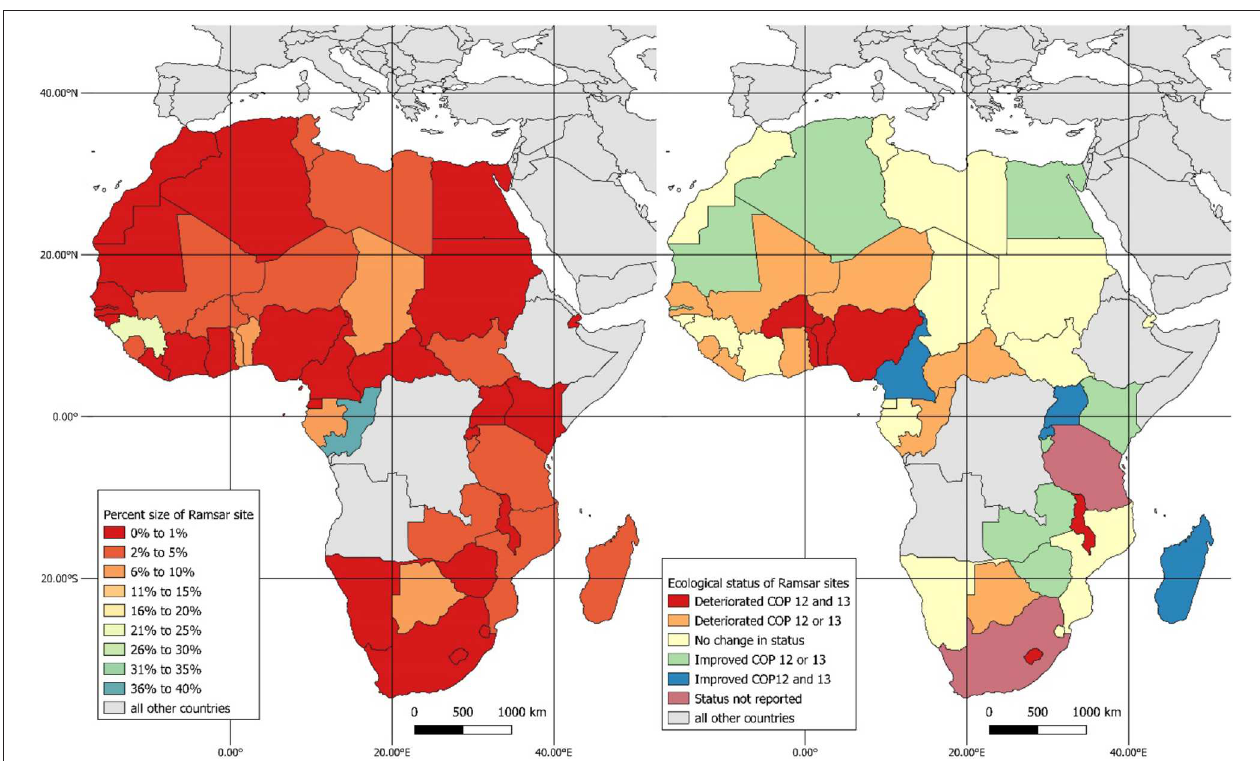
FIGURE 1 | Relative (percentage) size of inland Ramsar wetlands to country size (Left) . The change in ecological status of inland Ramsar wetland sites reported from COP 12 and COP13 (Right) . Countries where the status was not reported in both reporting periods are shown. For countries that reported in one of the two COPs, that value was included in calculating the change between reporting periods. The change between reporting periods was calculated as COP 12 plus COP 13 divided by two. Maps were produced using QGIS version 3.8 (QGIS Development Team,